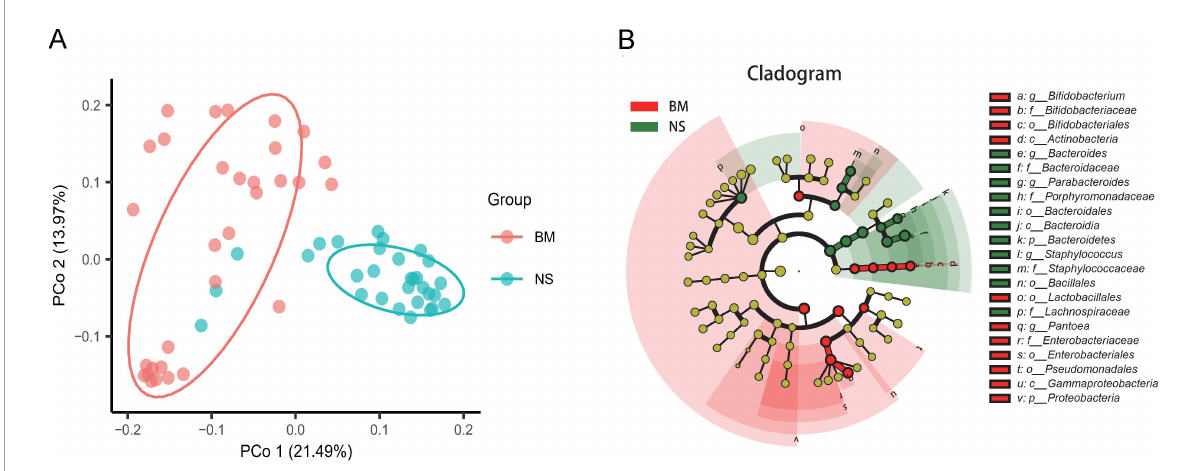
FIGURE3 Differences in the microbiota between BM (colostrum) and NS. (A) Unconstrained principal coordinate analysis with Bray–Curtis distance showing that the BM microbiota separated from those of NS in the first axis (21.49% of variance explained, P < 0.001, permutational multivariate analysis of variance (PERMANOVA) by Adonis; n = 31 in each group). Ellipses cover 68% of the data for BM and NS samples. The percentage of variation indicated in each axis corresponds to the fraction of the total variance explained by the projection. (B) Taxonomic cladogram from linear discriminant analysis (LDA) effect size (LefSe) showing microbiota differences in BM and NS taxa. Dot size is proportional to the abundance of the taxon. The yellow circles represent the classification with no significant difference. P, phylum; c, class; f, family; o, order; g,